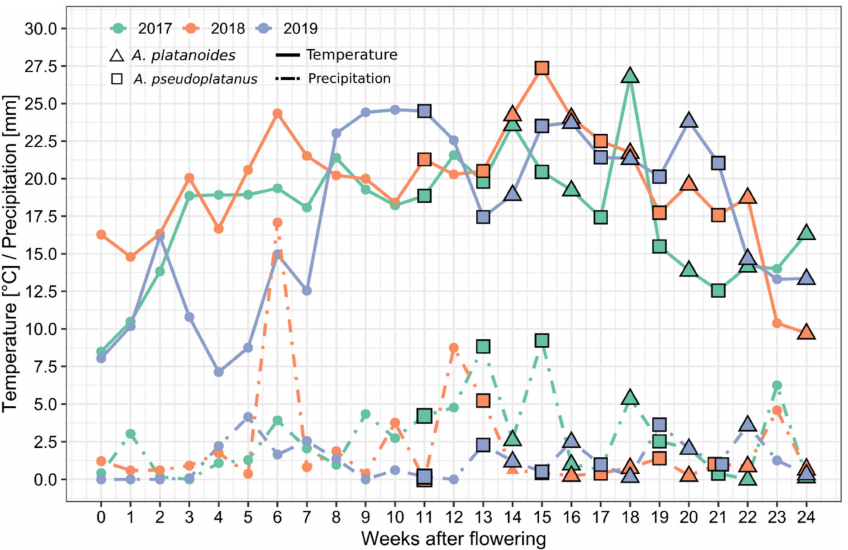
Figure 2. Weekly mean temperature (solid line) and mean precipitation (dashed line) during flowering and seed maturation in each experimental year. Seed samples for proline analyses were collected in weeks marked with symbols ( (cid:3) ) for Sycamore and ( (cid:52) ) for Norway maple.